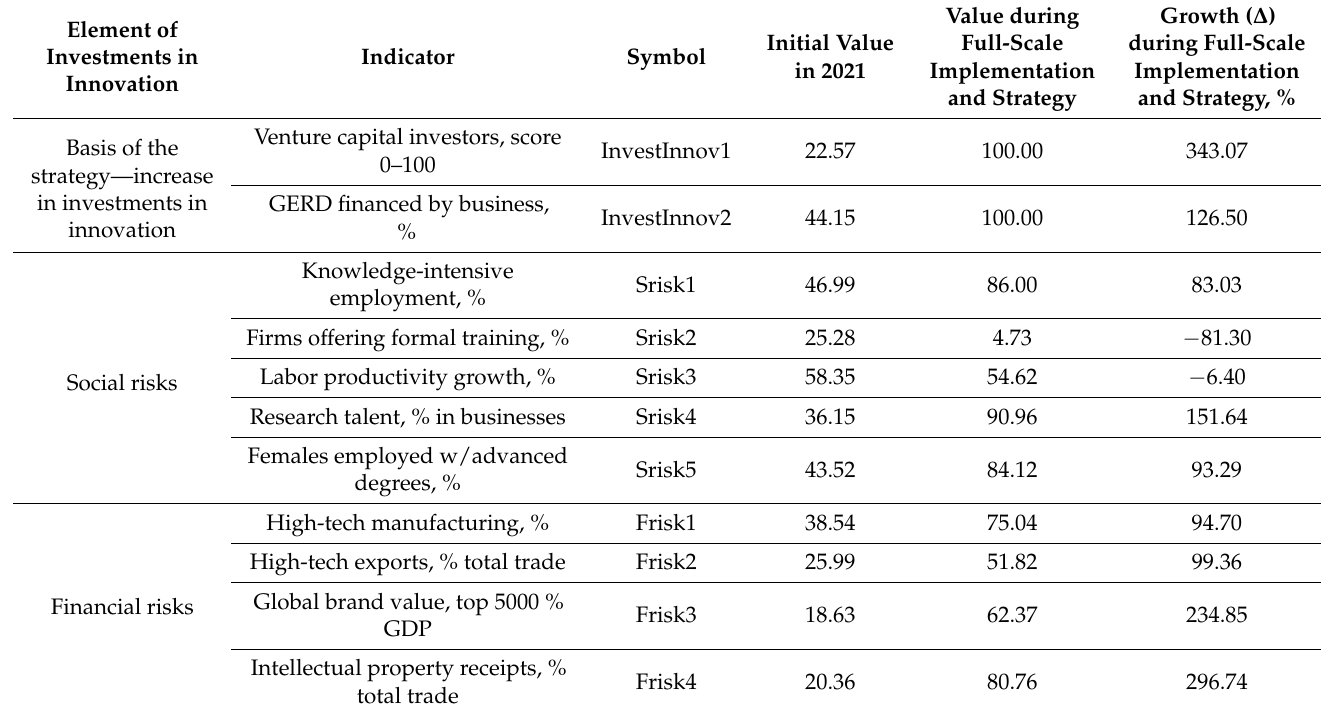
Table 9. Consequences of managing the financial risks—reduction of the influence of the “human factor” through automatization.